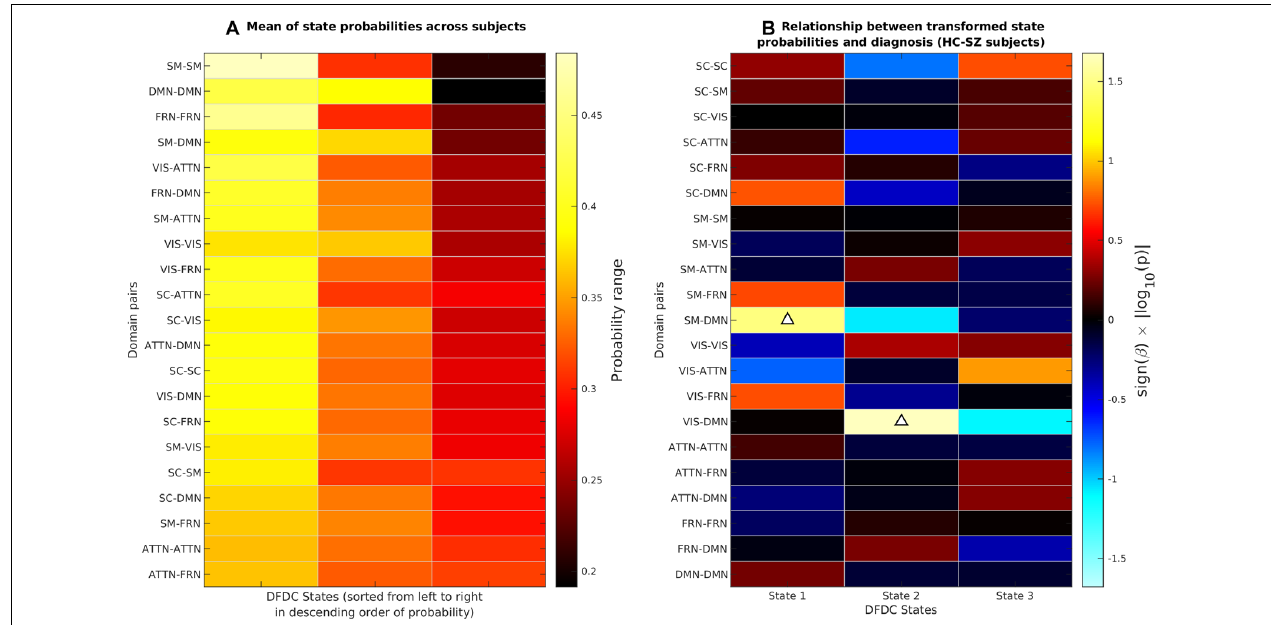
FIGURE 3 | (A) The DFDC state probabilities averaged across all subjects for each of the K = 3 states and DFDC domain pairs obtained using K -means clustering. The domain pairs are sorted from top to bottom in the order of increasing entropy. (B) Results obtained by regressing the diagnosis labels (HC-SZ) of the subjects on each of the DFDC state probabilities. The color intensity indicates sign ( β ) × | log10 ( p ) | where β is the coefficient of regression and p is the p -value corresponding to the t -statistic of the coefficient. Upward arrows indicate that in two cases SZ have significantly higher state probabilities than HCs ( p < 0.05,